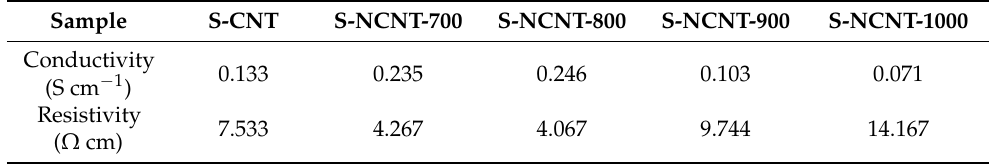
Table 3. Average electrical conductivity and resistivity of